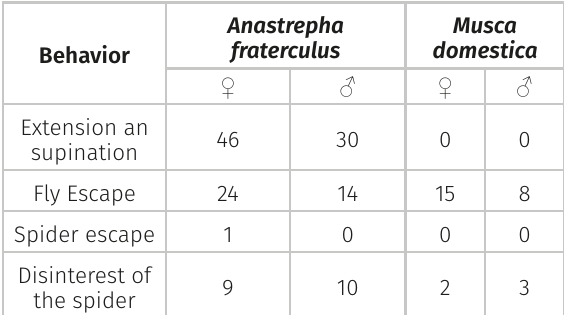
Table I. Number of events occurring when not preyed upon in the interaction between Anastrepha fraterculus and Musca domestica with Megafreya sutrix in laboratory. For each species 20 females and 20 males were used, totalizing 80